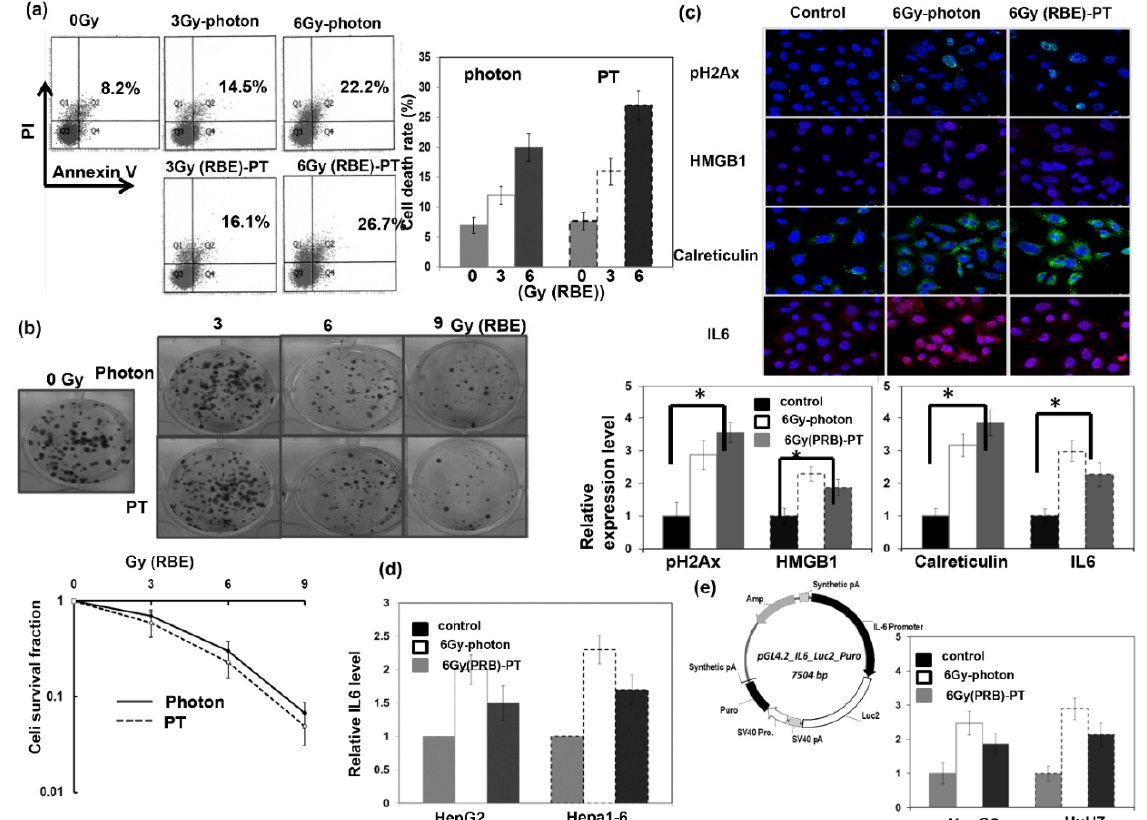
Figure 2. Response of HCC to PT in vitro. Effects of PT treatment on the cell death of HuH7 cells. ( a ) Fluorescence-activated cell sorting with propidium iodide and Annexin V staining 48 h after PT for the indicated dose (RBE), and ( b ) cell survival fractions by clonogenic assays presented with the ratio normalized by the survival fraction under control conditions. The plating cell numbers for 0, 3, 6, and 9 Gy (RBE) were 500, 1000, 1500, and 3000 per well, respectively. ( c ) Immunofluorescence for PT-induced DNA damage and markers for immunogenicity cell death are shown by representative slides and quantitative data (DAPI, blue; pH 2AX and calreticulin, green; HMGB1 and IL6, red). The y axis represents the relative fold changes in the target protein expressions. ( d ) The levels of IL-6 were examined via real-time RT–PCR 48 h after PT. ( e ) Stable transfection of HepG2 and HuH7 cells with plasmids containing IL-6 promoter–reporter constructs. Values are represented as fold activation of luciferase activity of the reporter plasmid in the indicated condition. Data are presented as means ± standard errors of the mean. * p < 0.05.